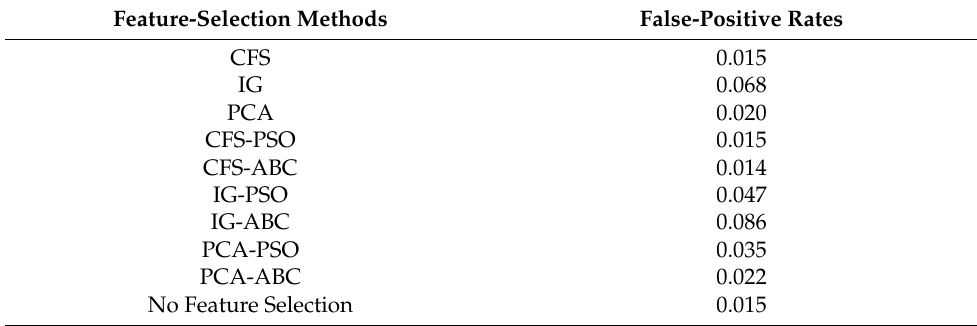
Table 5. False-positive rates of filter and filter–wrapper